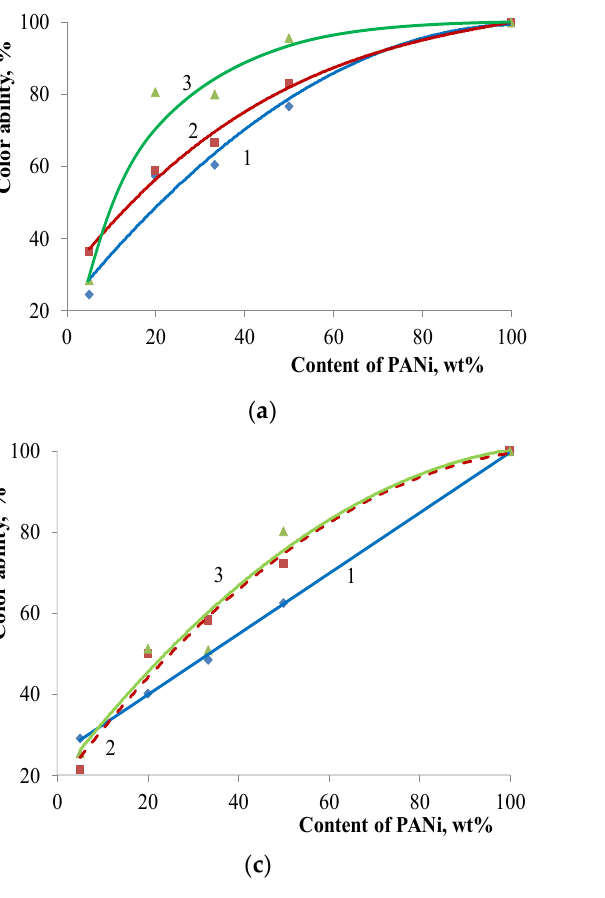
Figure 9. Hiding power of core/shell pigments with a various base vs. the content of PANi doped with various acids: ( a ) kaolin-based core/shell pigment; ( b ) bentonite-based core/shell pigment; ( c ) talc-based core/shell pigment; ( d ) muscovite-based core/shell pigment. Doping acid: (1)— Н 2 SO 4 ; (2)— НСl; (3)—H 3 PO 4 .